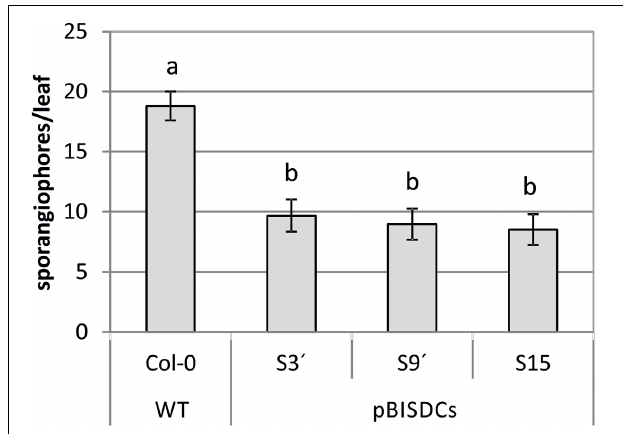
FIGURE 3 | Effects of H. arabidopsidis infection in Arabidopsis WT and pBISDCs transgenic lines overexpressing SAMDC1 (S3 (cid:2) , S9 (cid:2) , and S15). Fourteen-day old plants were inoculated with a conidiosporium suspension of H. arabidopsidis isolate Noks1 . Disease extension was estimated 10 days after inoculation by counting the number of sporangiophores developed in each leaf. Twenty-five leaves were sampled for each line. Graph shows the mean ± standard deviation. Significant differences between plant lines are indicated with letters (ANOVA, Tukey HSD test, p < 0 .